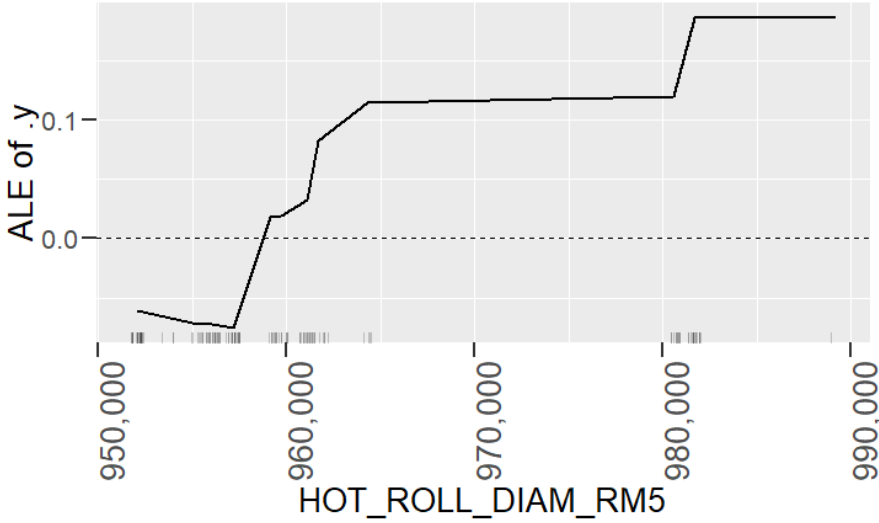
Figure 15. ALE of the diameter of the roll at the fifth roughing mill pass to the predicted roughness of GBM (black solid line) on the Y -axis and the distributions of data points (black bars) on the X